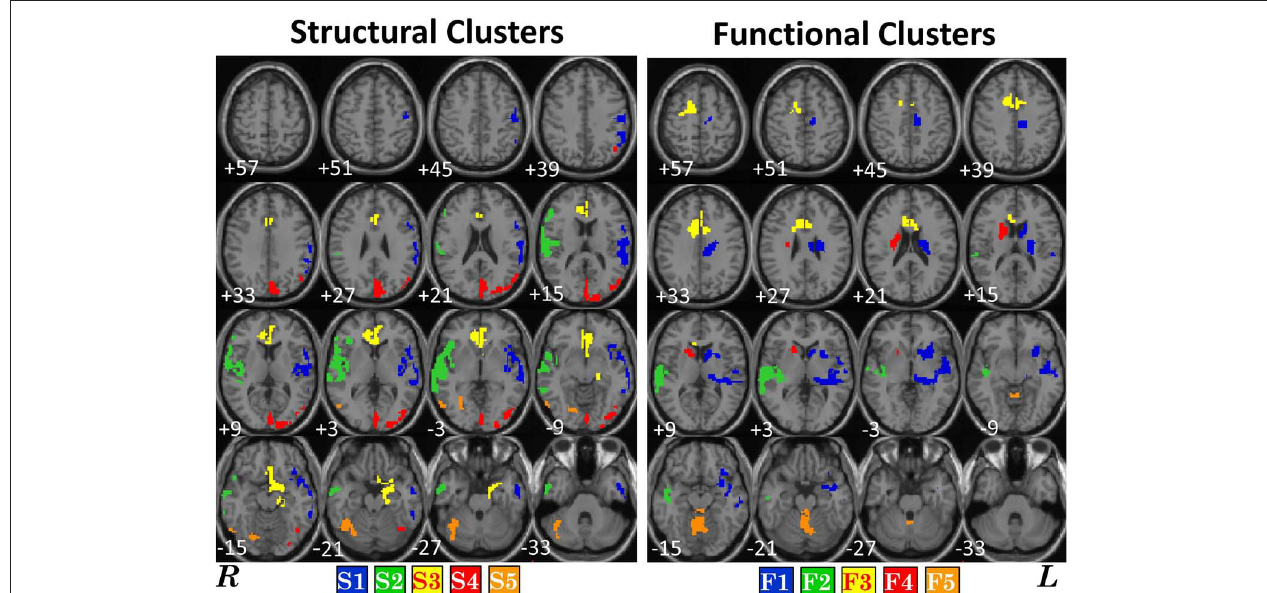
some of the spatially similar structural and functional clusters are given the same color, but they do not relate in any other way. In Section “Structure– Function Inter-Cluster Correlations for Probe Medium” we present that correlation between these structural and functional clusters is positive in HC and negative